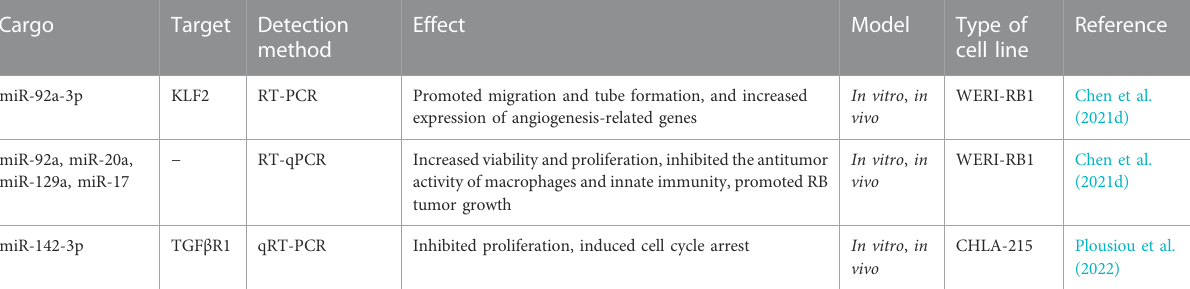
TABLE 4 The role of exosomal ncRNAs in